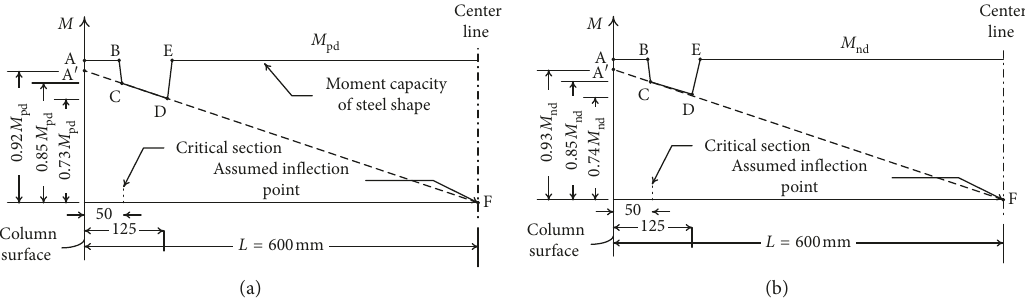
Column surface Figure 6: Design moment capacity distribution of the beam with WBC connection. (a) Steel shape; adapted from [15]. (b) Whole